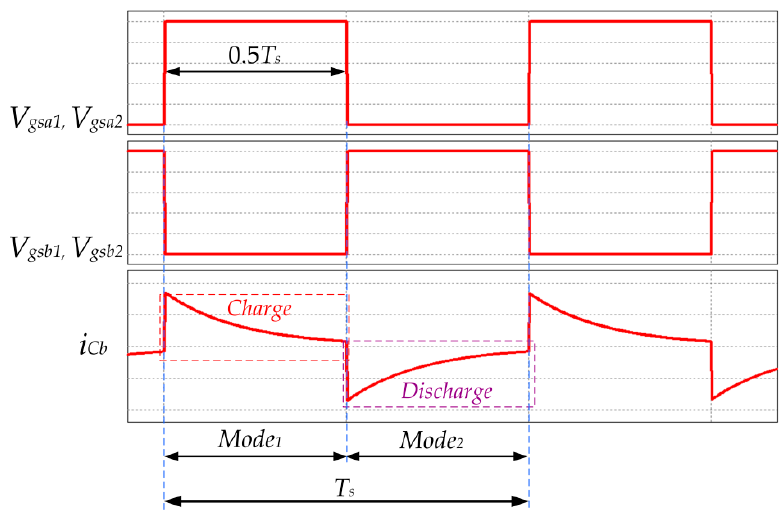
Figure 6. Operational waveforms of the switched-capacitor circuit.